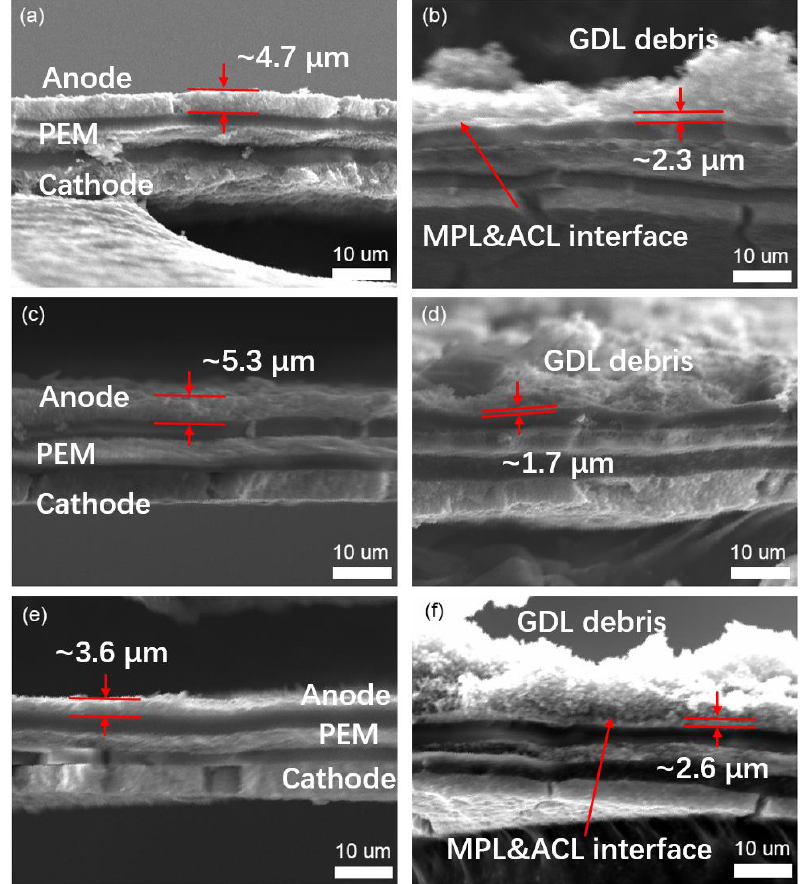
Figure 5. Cross-section images of fresh and aged MEAs with different RTA structures: fresh MEA sample for hybrid-RTA ( a ), layered-RTA ( c ), and GDE-RTA ( e ). MEA samples after reversal AST for hybrid-RTA ( b ), layered-RTA ( d ), and GDE-RTA ( f ).